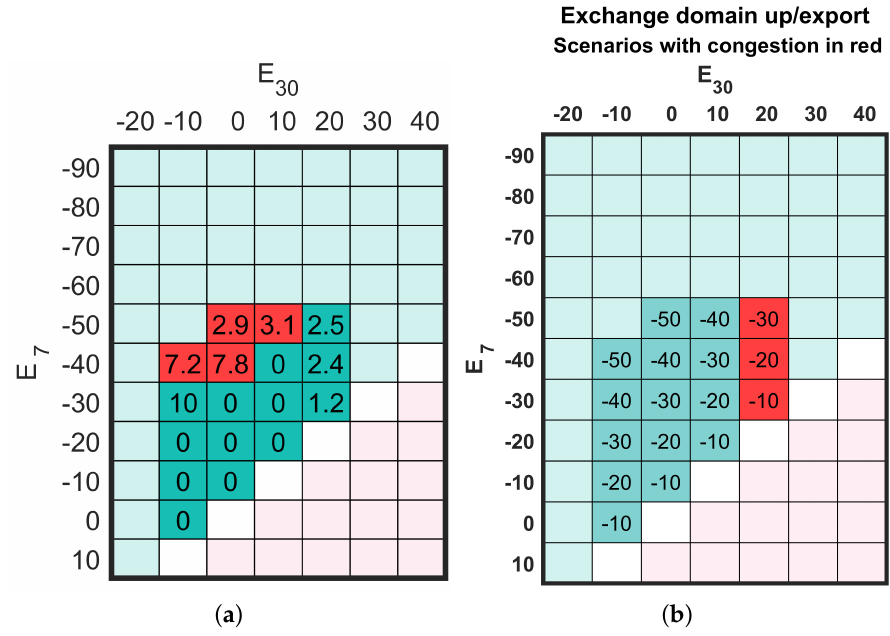
Figure 4. ( a ) Activation volume of Bid #4, causing congestion in red scenarios; ( b ) Feasible exchange scenarios after filtering Bid